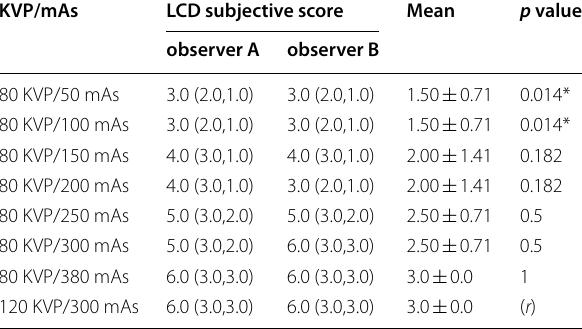
Table 6 Comparison of SNR between 120 and 80 KVP